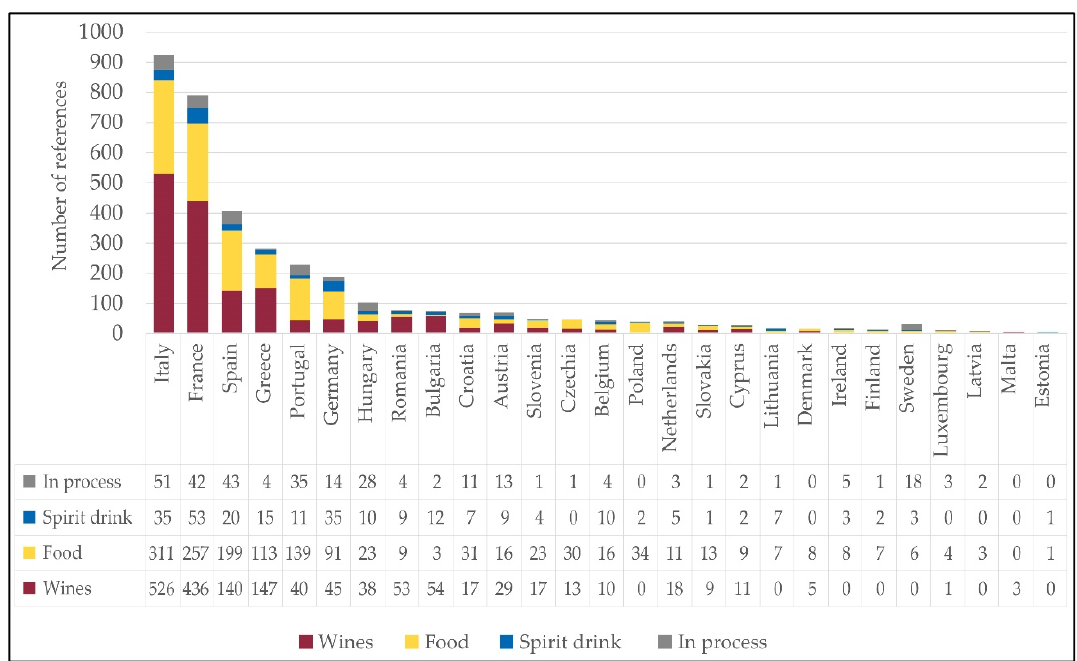
12 of 30 Figure 4. Percentage significance of differentiated quality products protected in the EU by geo- graphical indication, category, and registration subcategories. Source: Data from the European